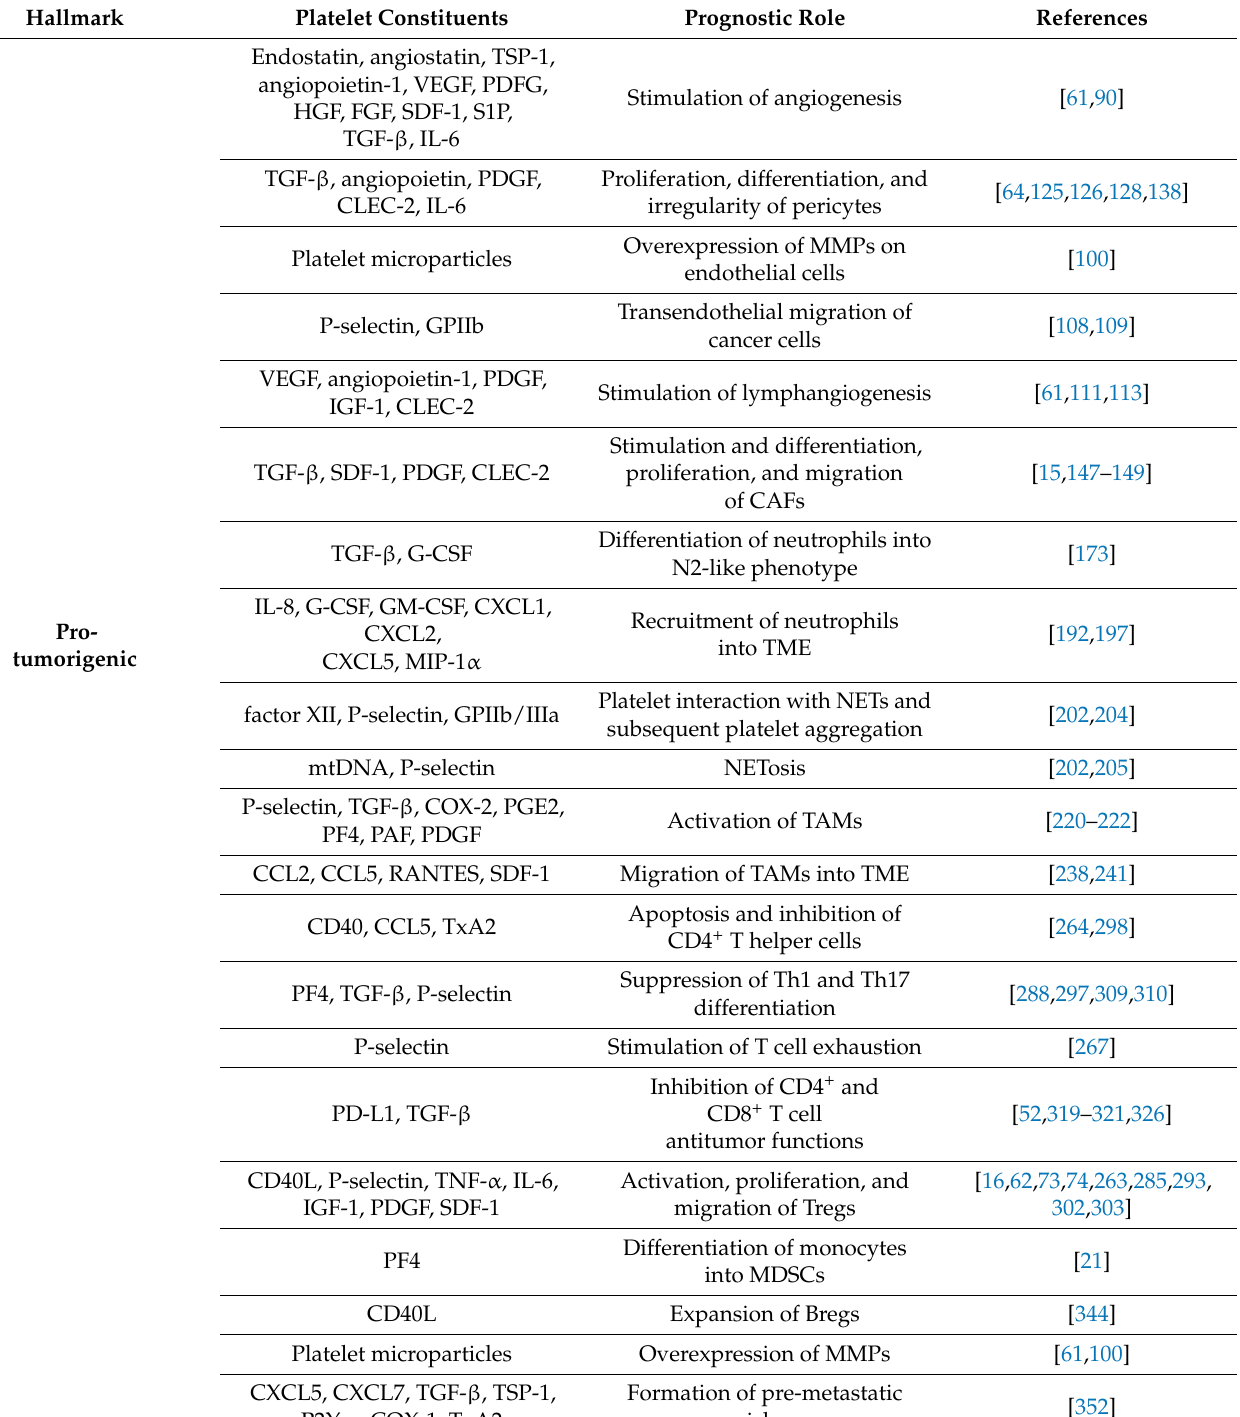
Table 2. The influence of various platelet-associated molecules on TME in